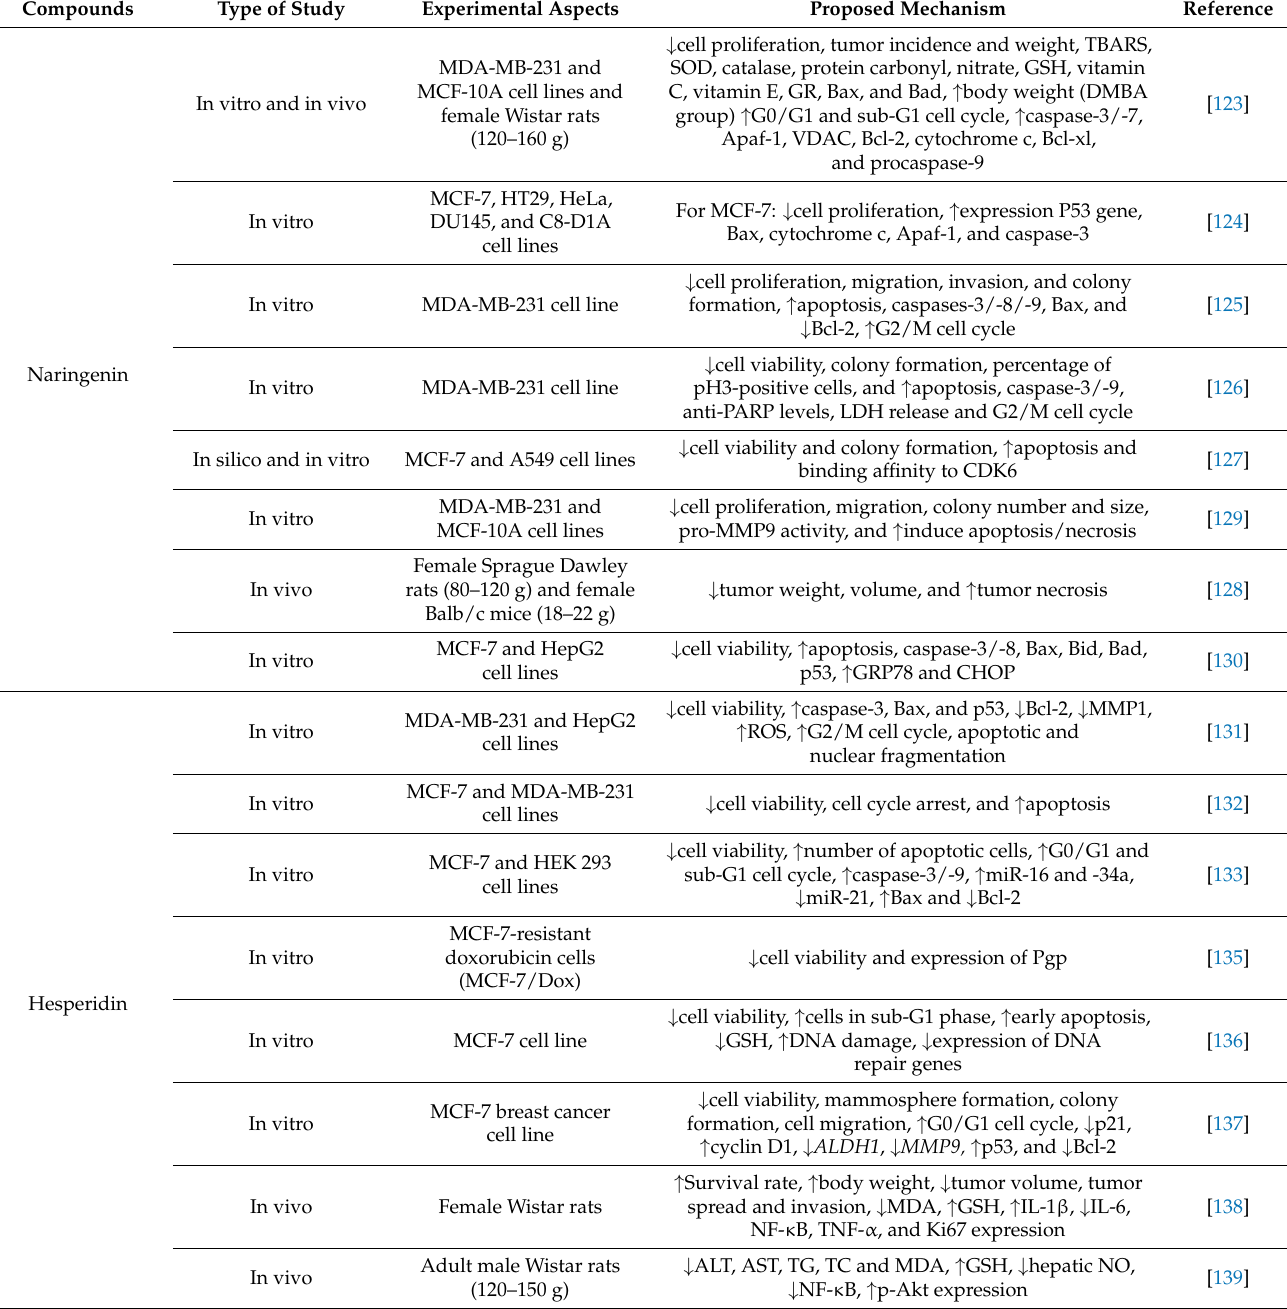
Table 2. Summary of the mechanisms of naringenin and hesperidin in different